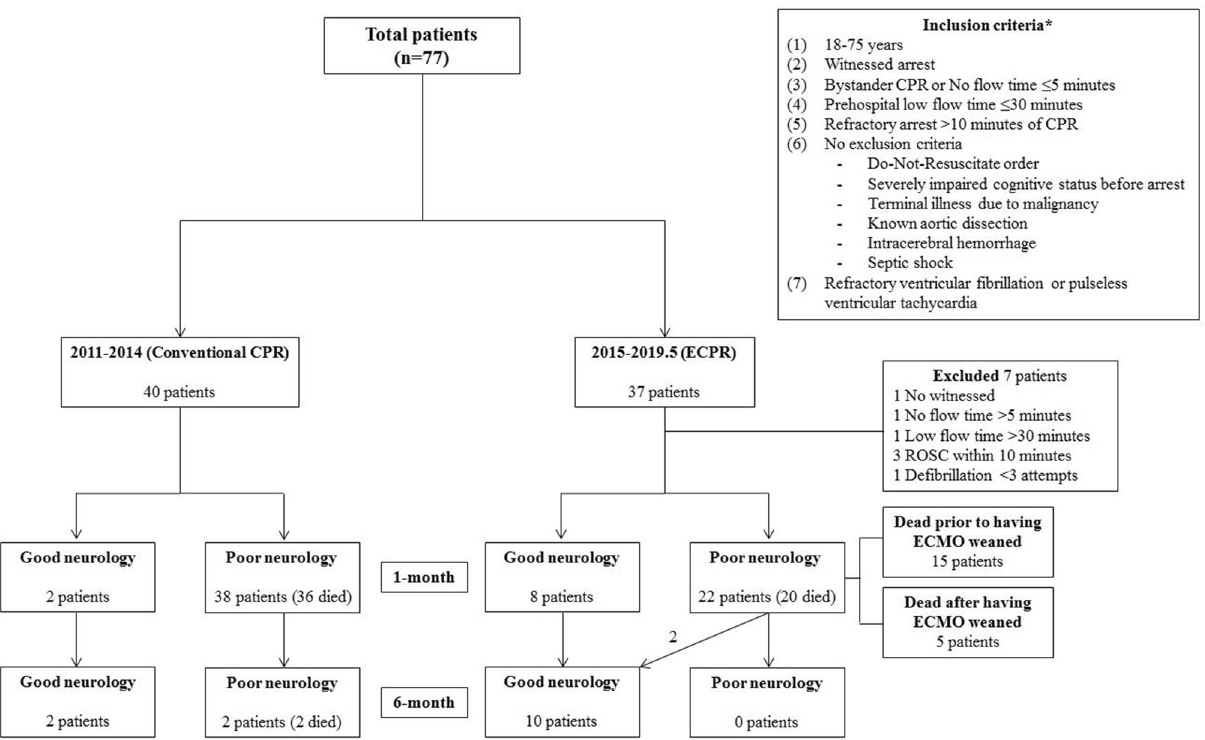
Figure 1. Flow diagram of patients included in our study. *All from (1) to (6) have to be met, or (7) has to be met. CPR cardiopulmonary resuscitation, ECPR extracorporeal cardiopulmonary resuscitation, ROSC return of spontaneous circulation, ECMO extracorporeal membrane